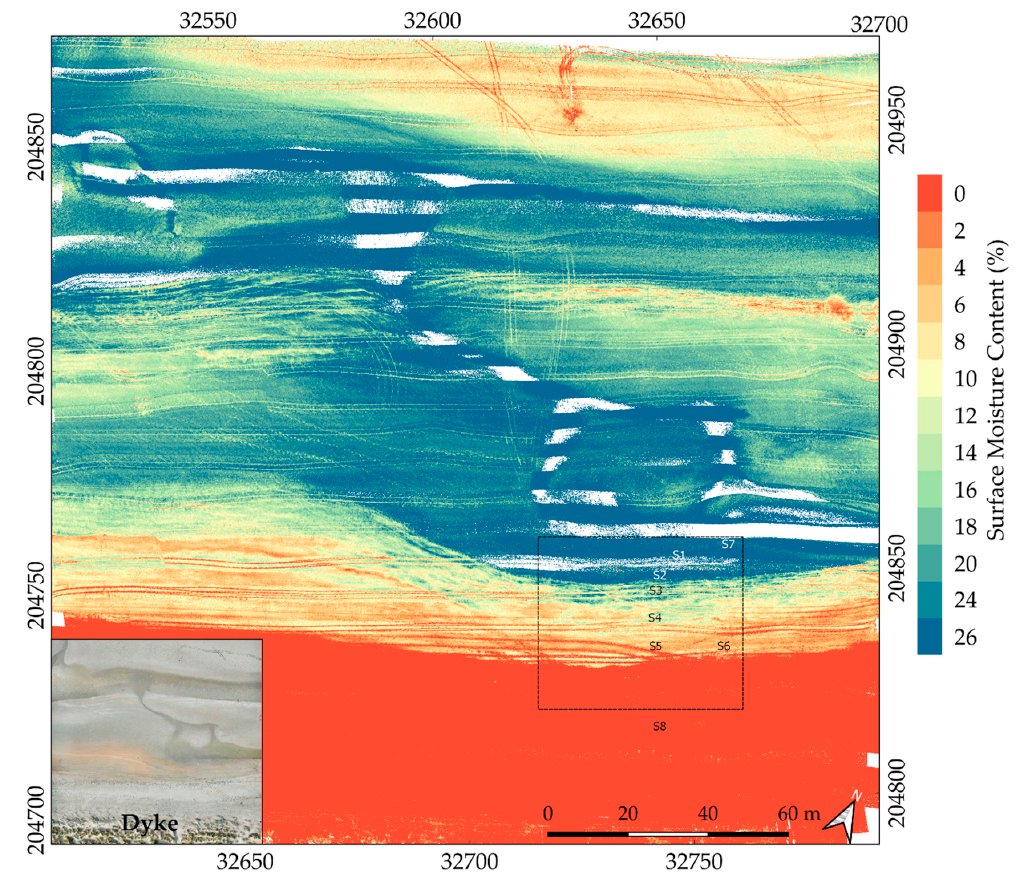
Figure 13. The beach surface moisture map of 200 × 200 m on the beach of Groenendijk, Belgium based on 24 survey lines of MTL. In the left corner, a simultaneously acquired orthophoto of the study site is given where we clearly see the distribution of the trough. The black dotted box indicates the repeated scanning area and the points S1–S8 localize the eight sampling sites.